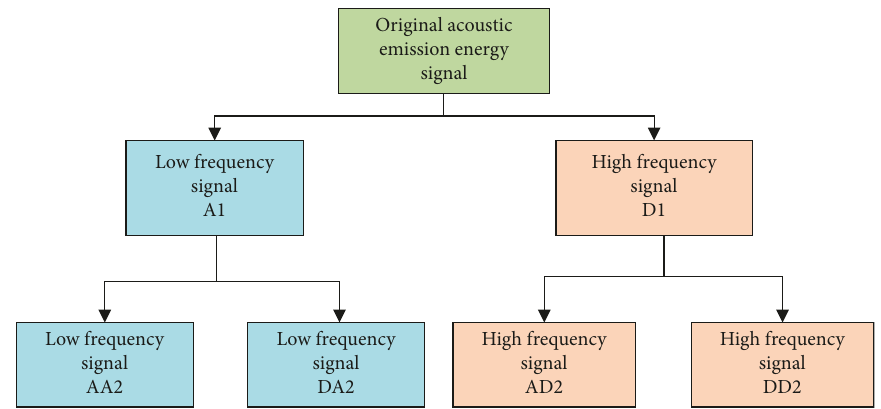
Figure 1: Schematic diagram of wavelet packet